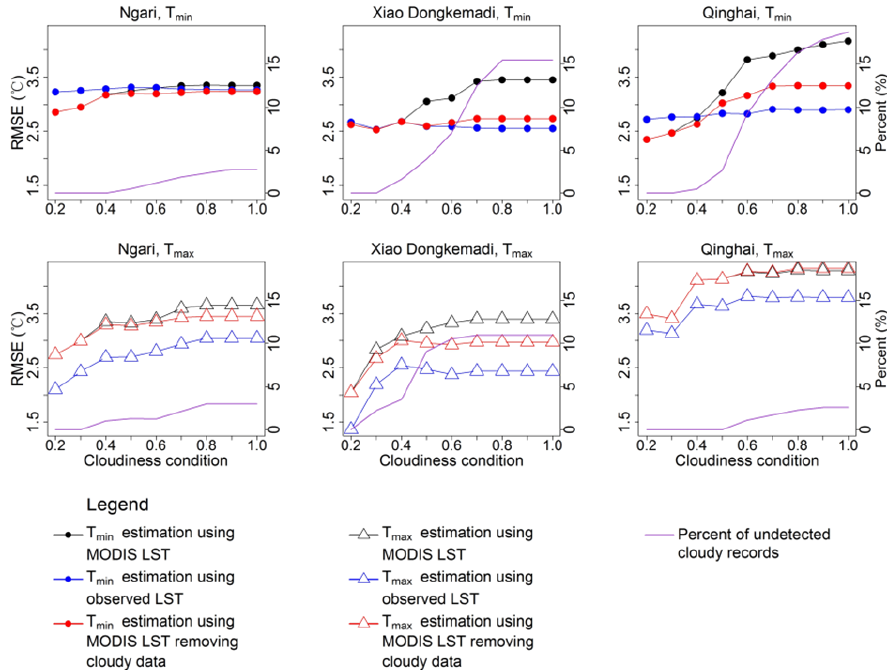
Figure 8. Comparisons between T min and T max estimation accuracies based on MODIS LST, MODIS LST without cloudy data, and observed LST under different cloudiness conditions for the three